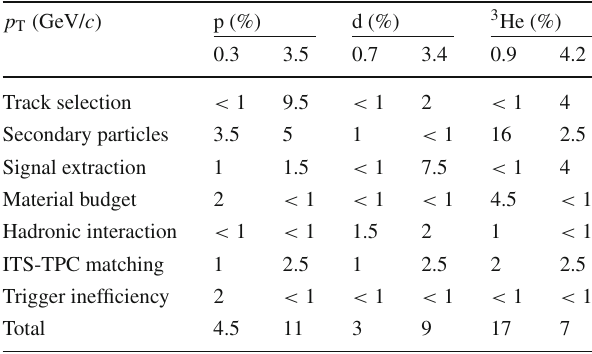
Table 2 Summary of the contributions to the systematic uncertainties of the yield for the INEL > 0 event class for the different species